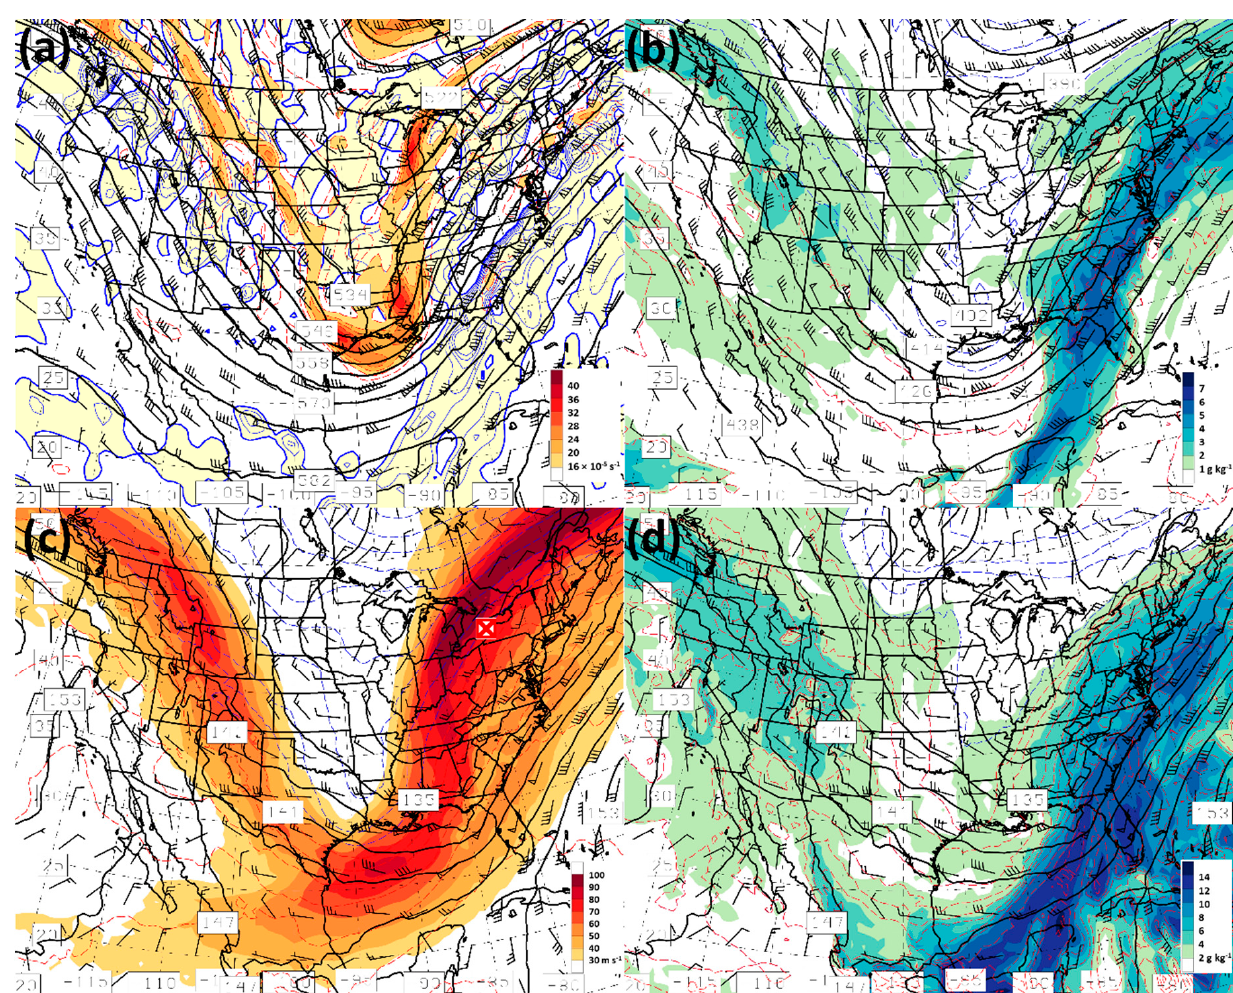
Figure 7. As in Figure 3, except GFS − analyzed fields valid at 0000 UTC 7 February 2020 of: ( a ) 500 hPa level geopotential height (dam, solid black contours), absolute vorticity × 10 − 5 (s − 1 , shading and red dashed contours), and wind vectors (kt) and 700 hPa level rising motion × 10 − 3 (hPa s − 1 , vanilla shading and blue solid contours); ( b ) 600 hPa level geopotential height (dam, solid black contours), mixing ratio (g kg − 1 , shading), equivalent potential temperature (K, final blue (first red) dashed contour value is 304 K (310 K)), and wind vectors (kt); ( c ) 850 hPa level geopotential height (dam, solid black contours) and wind vectors (kt) and 1000-500 hPa layer thickness (dam, final blue (first red) dashed contour value is 540 dam (546 dam)), and 300 hPa level wind speed (m s − 1 , shading); and ( d ) 850 hPa level geopotential height (dam, solid black contours), mixing ratio (g kg − 1 , shading), wind vectors (kt), and equivalent potential temperature (K, final blue (first red) dashed contour value is 280 K (286 K)). Red cross-square symbol in panel ( c ) represents the locally dominant 850 hPa level cyclone center.